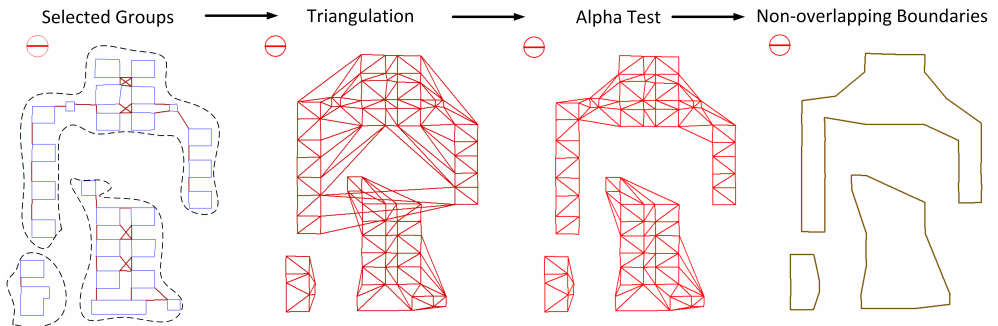
Figure 10. The boundary generation of three obstacle groups for a user with a size of 0.8 m.